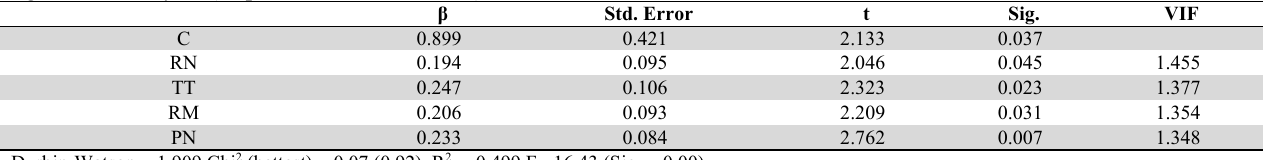
Regression Analysis (Dependent Variable: BFP) β Std. Error t